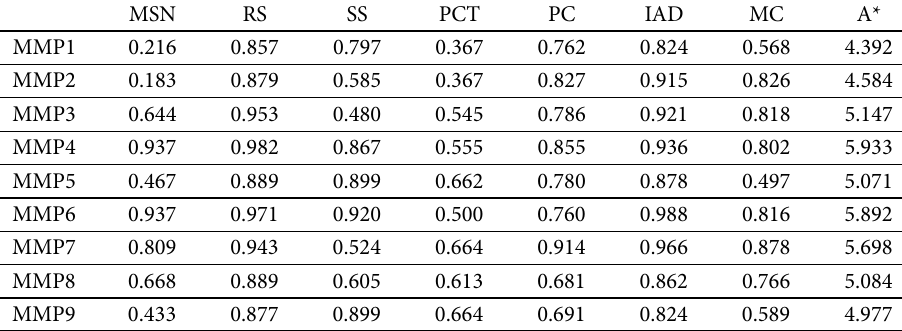
Table 12. The distance measurements from FPIS